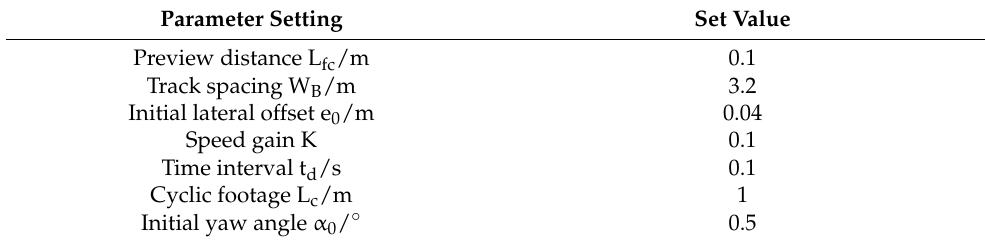
Table 1. Simulation parameter